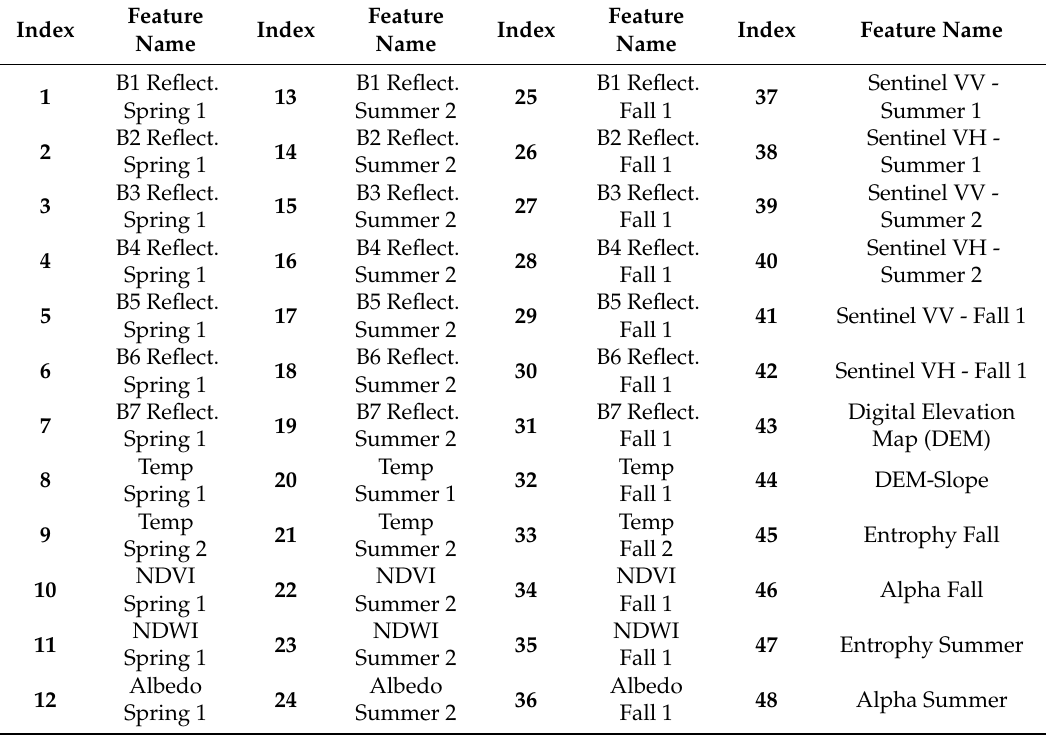
Table 3. Image Input features used during this study and their associated variable